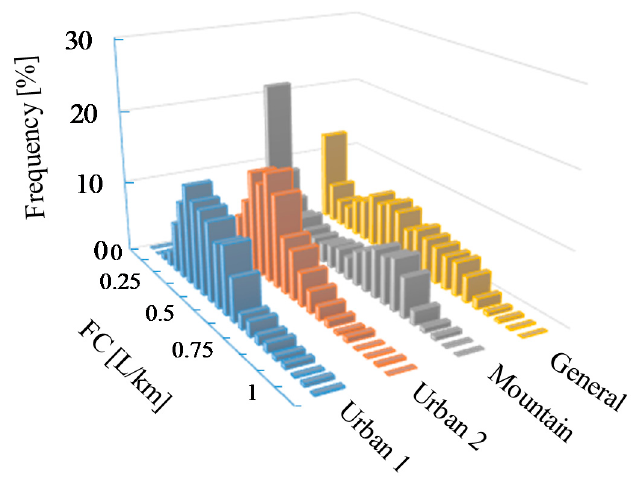
Figure 1. Frequency distribution of the FC s measured of all trips considered in this study.